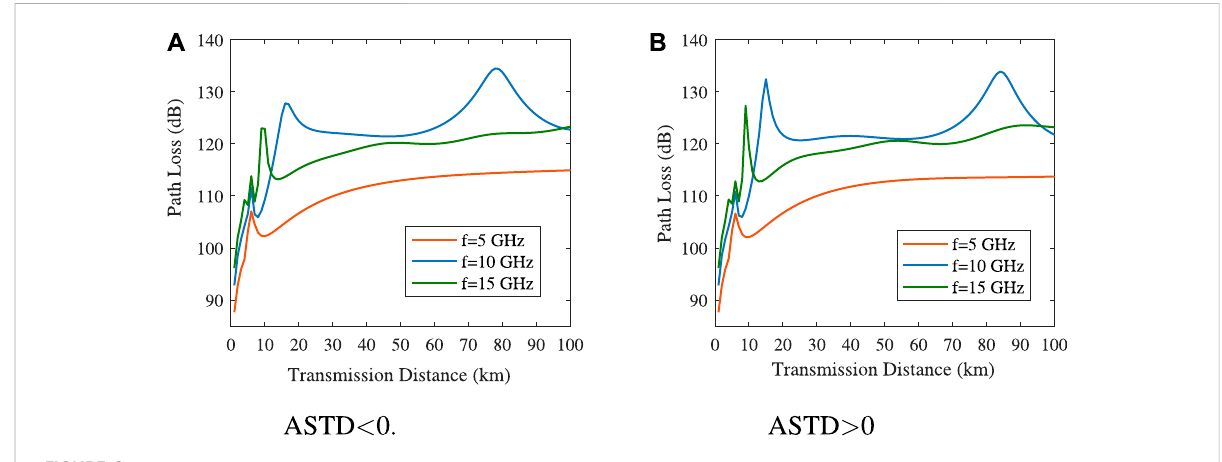
FIGURE 6 Variation in path loss with transmission distance in different states. (A) ASTD < 0. (B) ASTD > 0.